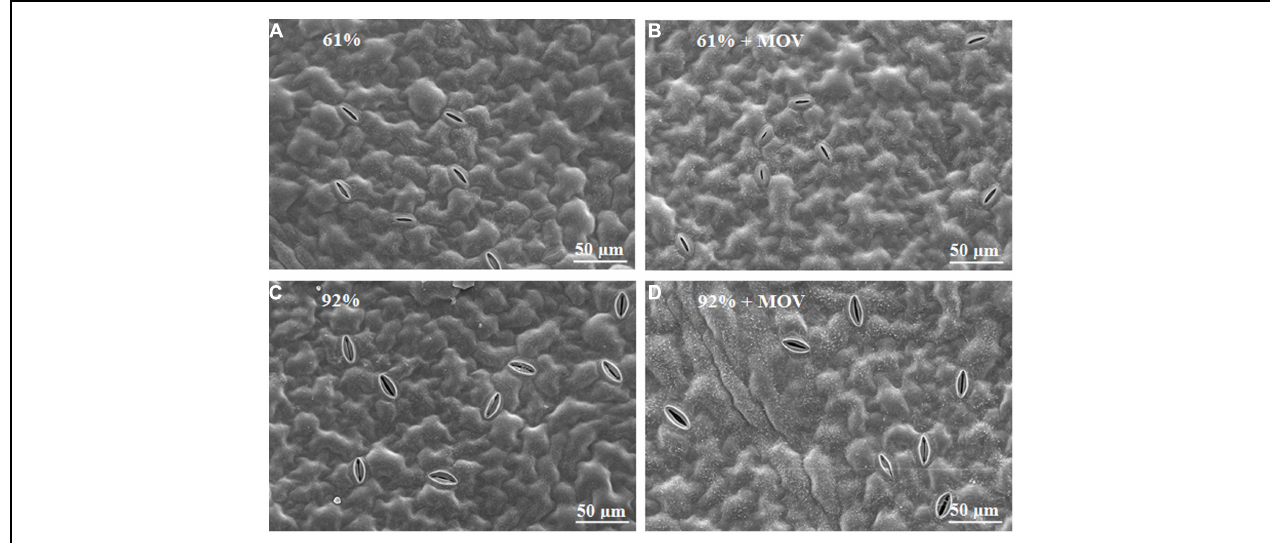
FIGURE 3 | Morphology of the abaxial leaf surface in pot rose cv. ‘Toril’ grown at moderate (61%; A,B) or high (92%; C,D) RH combined with no additional MOV (A,C) or with additional MOV ( + MOV; B,D). Images were obtained by scanning electron microscope.